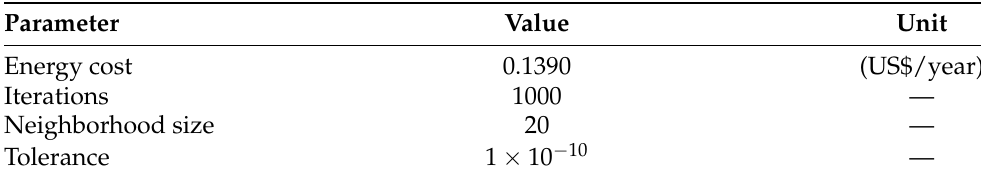
Table 5. General simulation